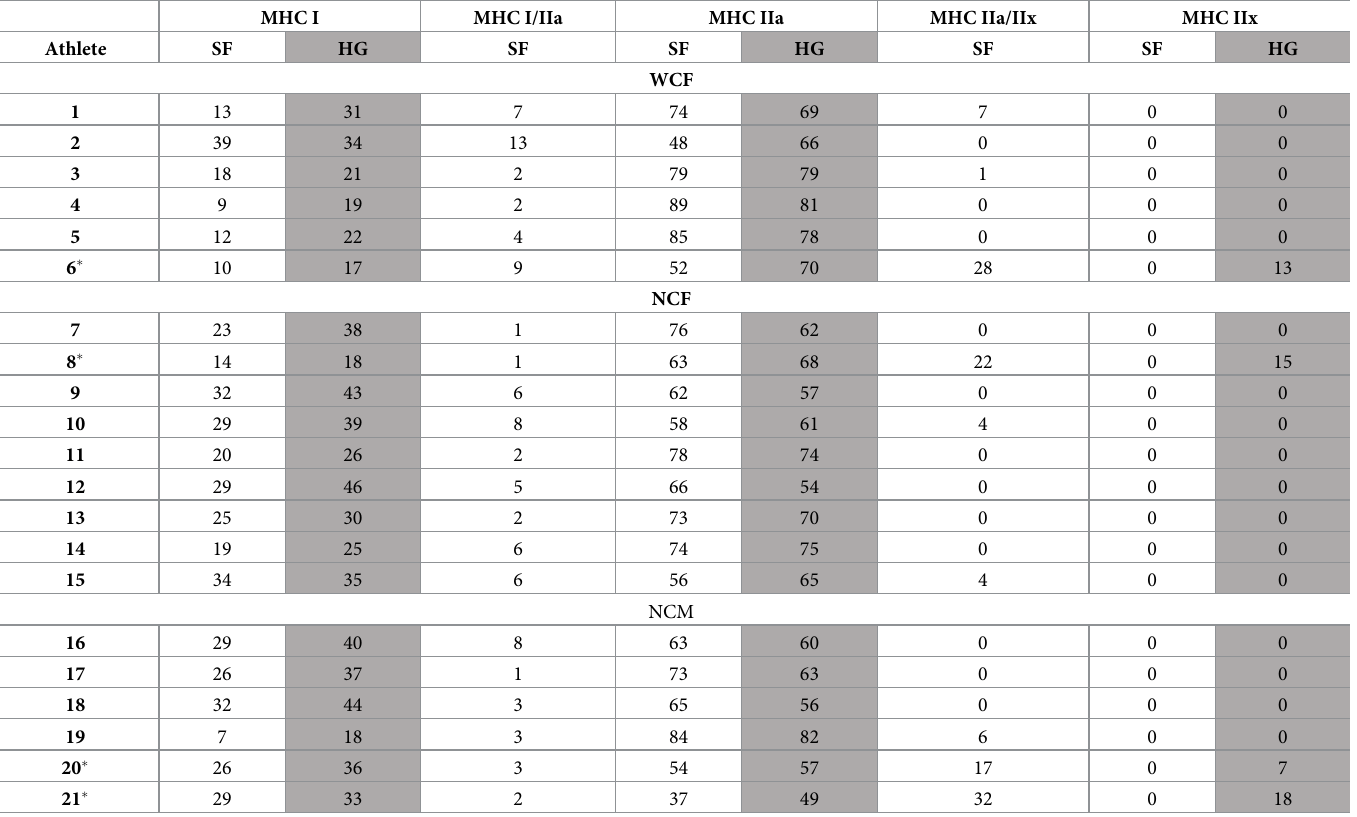
Table 3. Individual FT% of elite female and male American weightlifters. Data are reported as a